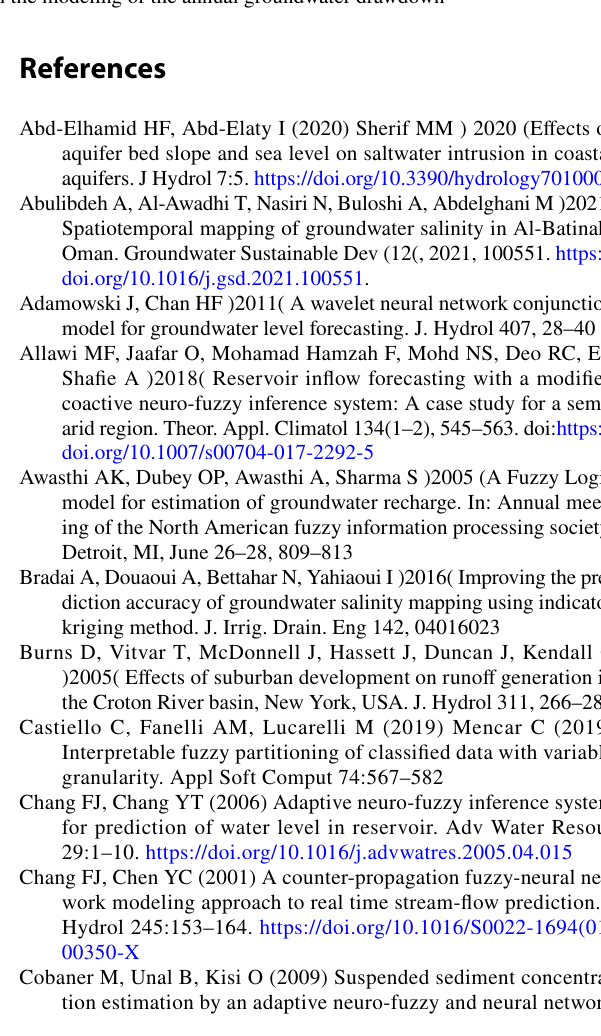
Fig. 5 Annual groundwater drawdown map (m) in the study area. The observed values of annual drawdown in the studied wells have been over- lapped with the map for evaluating the accuracy of the obtained results in the modeling of the annual groundwater